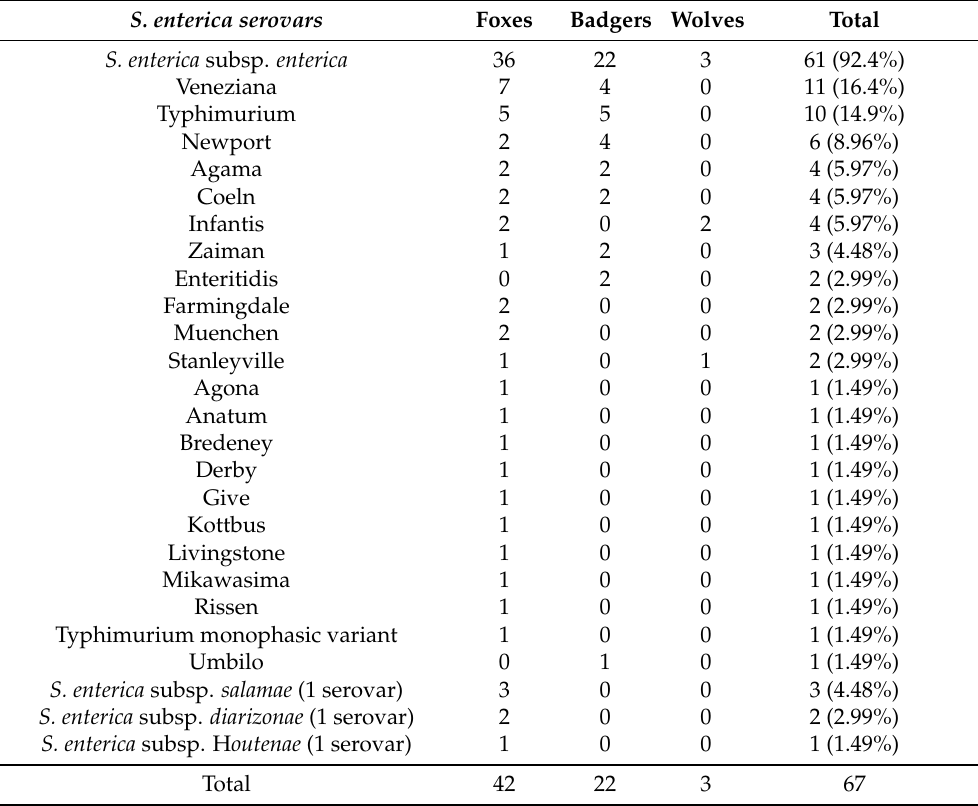
Table 1. Salmonella subspecies and serotypes isolated from foxes, badgers and